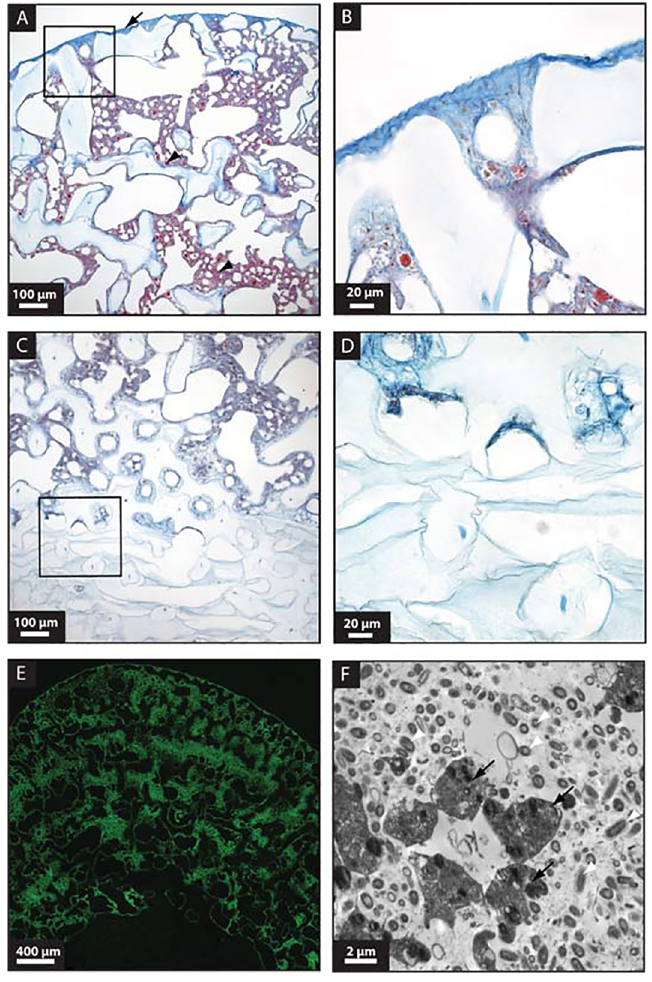
Fig 5. General histological features of decalcified Vaceletia sp. (A) Alcian blue stained section of a sagittal sectioned individual illustrating the head region. Blue staining reveals acidic mucopolysacharrides and likely reflects the location of previously calcified pillars (see Fig 1I). Intense red stain reveals sponge larvae (arrowhead) and sponge tissue. (B) Magnification of the boxed section in A illustrates the more intense blue staining in the outermost head region where the acidic substance is produced. (C) Alcian blue staining in the stalk region is less intense than in the head region. (D) Magnification of the boxed section in C shows that the previously calcified stalk region contains no red stained sponge tissue. (E) Sagittally sectioned individual shows the autofluorescent sponge tissue in the head region and a lack of cells in the stalk region. (F) TEM image of sponge mesohyl filled with darkly stained sponge cells (black arrows) and diverse and abundant bacteria (white arrowheads).